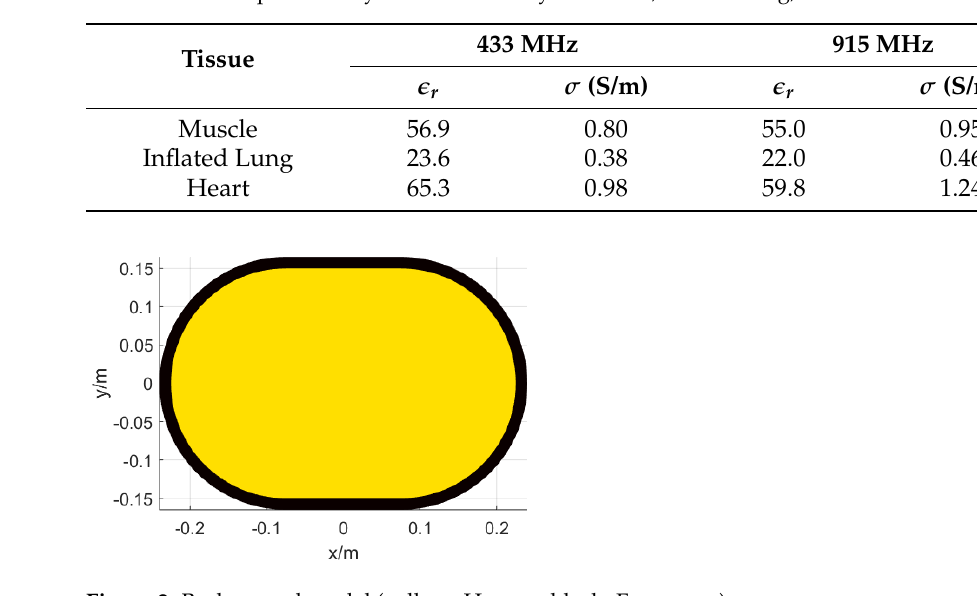
Figure 2. Background model (yellow: Human; black: Free